Question: Provide a one-line summary of what is displayed.
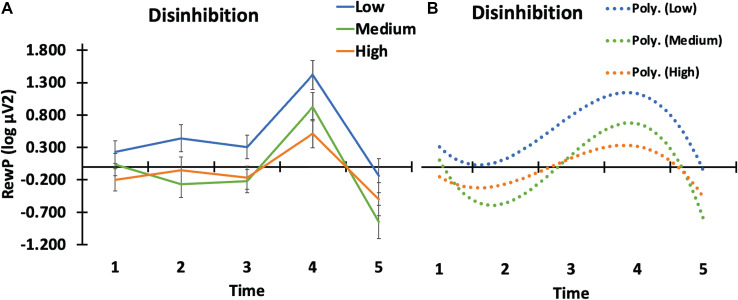
Answer: long description. EEG power of disinhibition group on RewP . Note: The Y axis represents the EEG (log µV 2 ) for the measure of the GAS – reward positivity (RewP). The X axis presents the time points (ms): 1 = 0–70; 2 = 70–100; 3 = 100–200; 4 = 200–300; 5 = 300–400. Disinhibition groups are: low (blue); medium (green; and high (orange). Poly. = polynomial. A = findings for disinhibition group on EEG measure for GAS. B = polynomial trend for each disinhibition group: low (blue); medium (green); and high (orange). Error bars represent standard error.